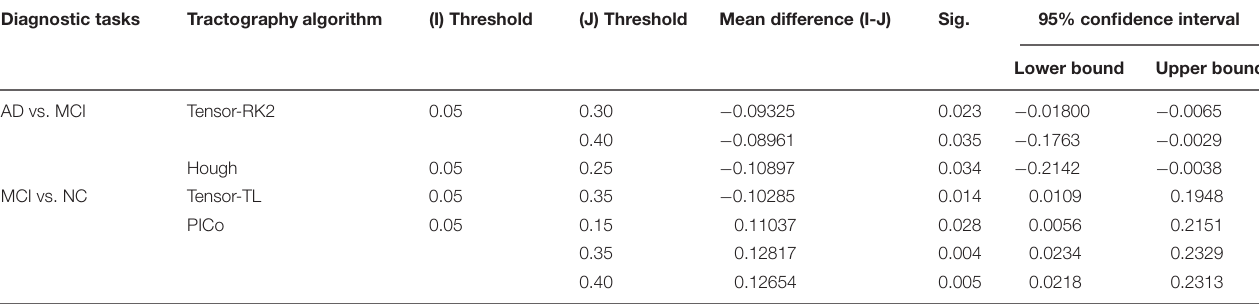
TABLE 4B | Post hoc comparison results for the Individual Binary Threshold